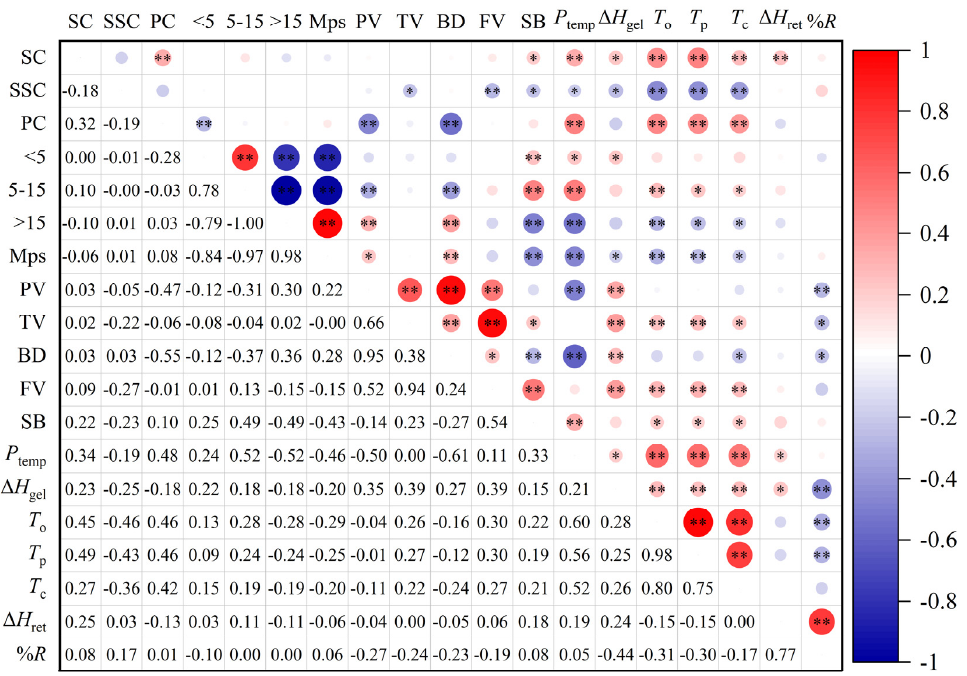
Figure 3. Correlation coefficients of grain quality parameters. SC: starch content; SSC: soluble sugar content; PC: protein content; <5: volume percentage of starch less than 5 µ m; 5–15: volume percentage of starch between 5–15 µ m; >15: volume percentage of starch more than 15 µ m; Mps: mean particle size; PV: peak viscosity; TV: trough viscosity; BD: breakdown viscosity; FV: final viscosity; SB: setback viscosity; P temp : pasting temperature; ∆ H gel : gelatinization enthalpy; T o : onset temperature; T p : peak gelatinization temperature; T c : conclusion temperature; ∆ H ret : retrogradation enthalpy; % R : retrogradation percentage. * and ** represent significance at the 0.05 and 0.01 probability levels.